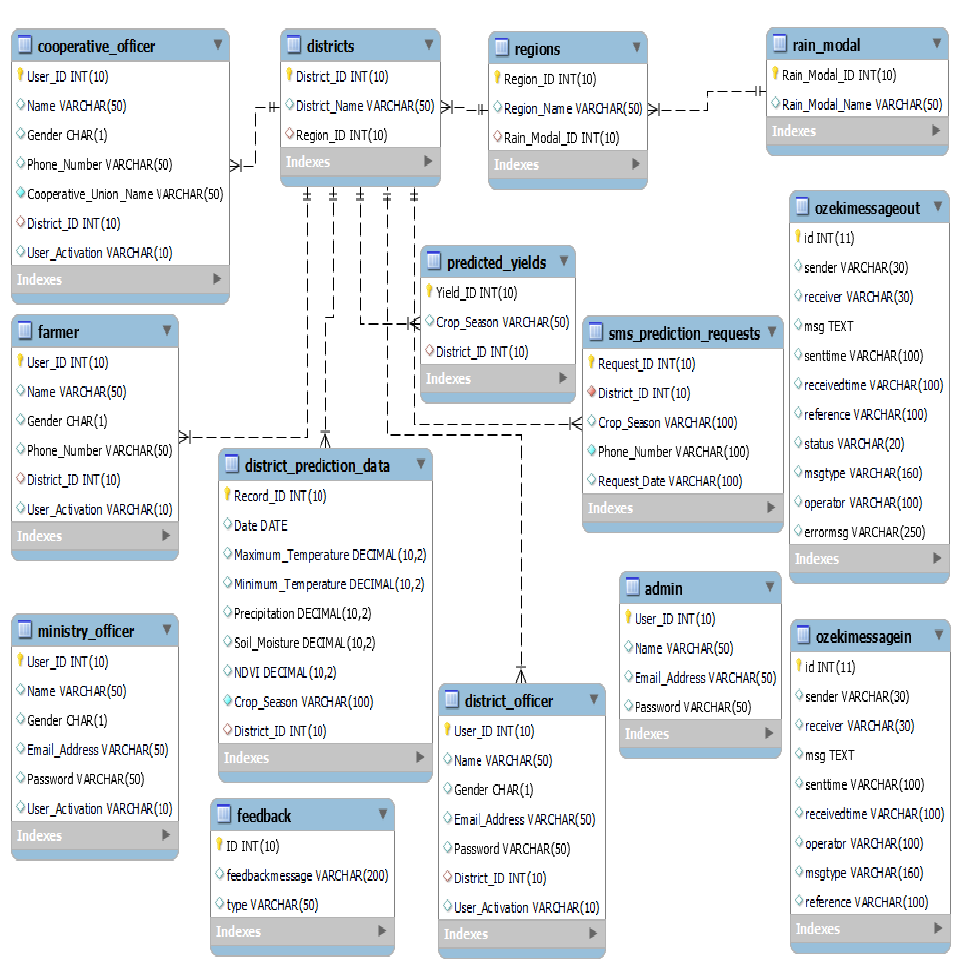
Figure 10. System design using three-tier architecture.